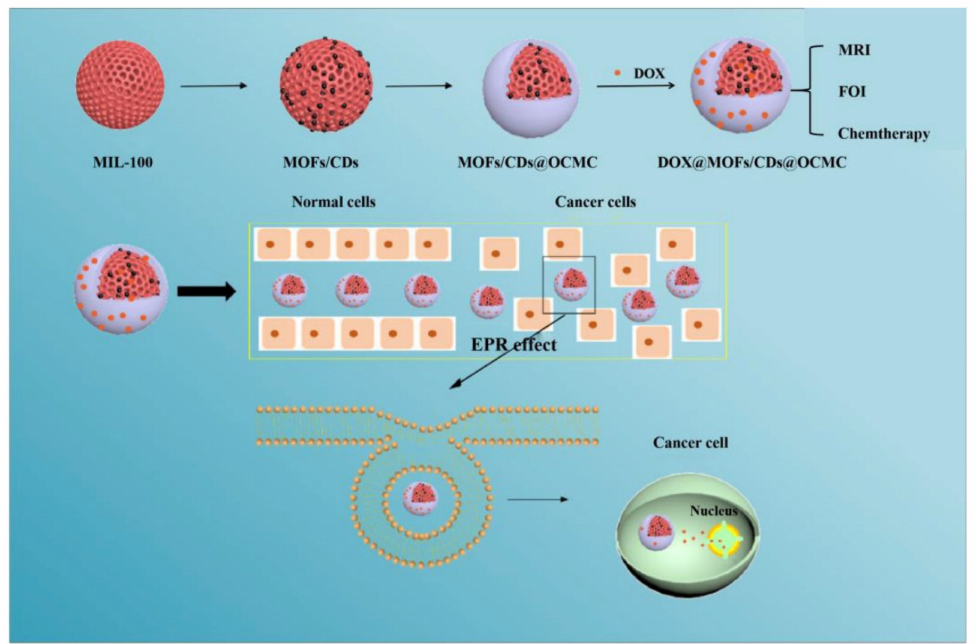
Figure 22. Schematic illustrated the preparation of the MOFs/CDs/OCMC nanocomposites and their application as drug carriers of DOX for the treatment of cancer [141]. Reproduced with permission from Elsevier